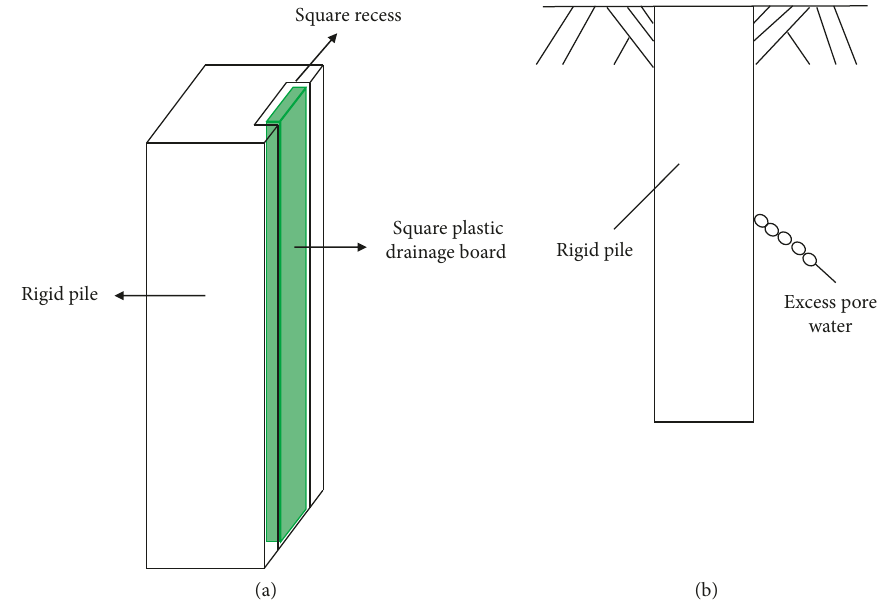
Figure 5: The operating principle of drainage rigid piles. (a) Composition of drainage rigid piles. (b) Principle of excess pore water dissipation.